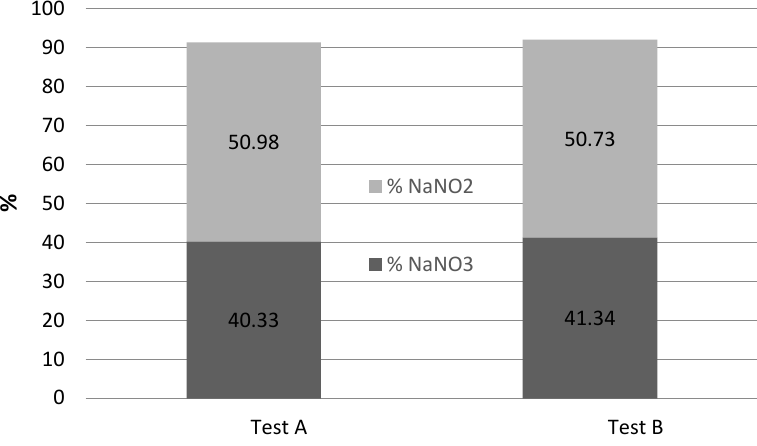
Figure 8. Amount of NaNO 2 - NaNO 3 and NaOH salt formation (obtained from chemical analysis and ionic balance).